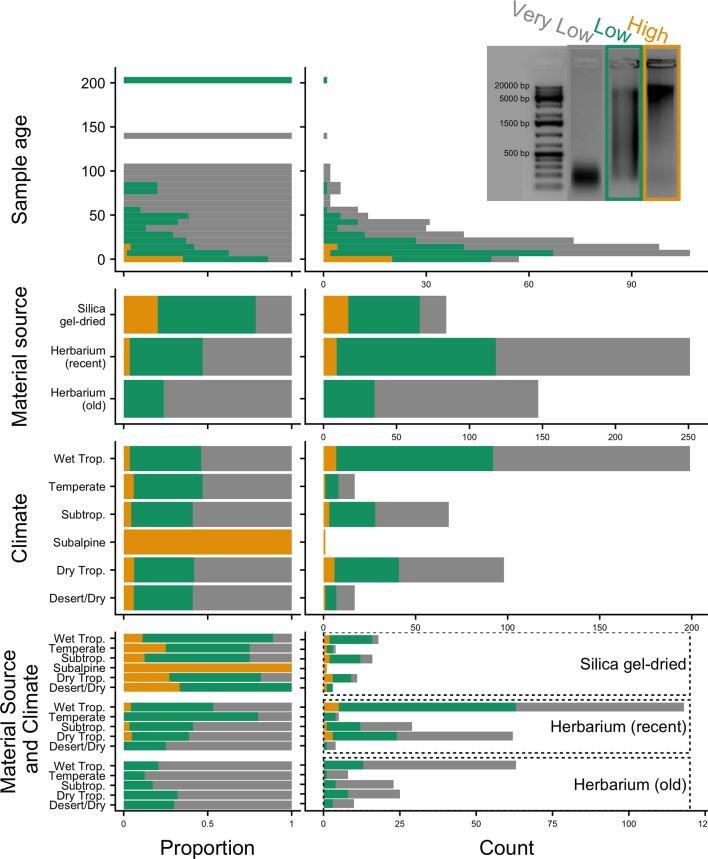
Genomic DNA quality according to sample age, material source, climate (according to species distributions), and material source and climate combined, in relative (proportion) and absolute (count) values. Quality is defined as very low (severely fragmented DNA <500 bp), low (DNA smear on agarose gel), or high (high-molecular-weight DNA >5 kbp).